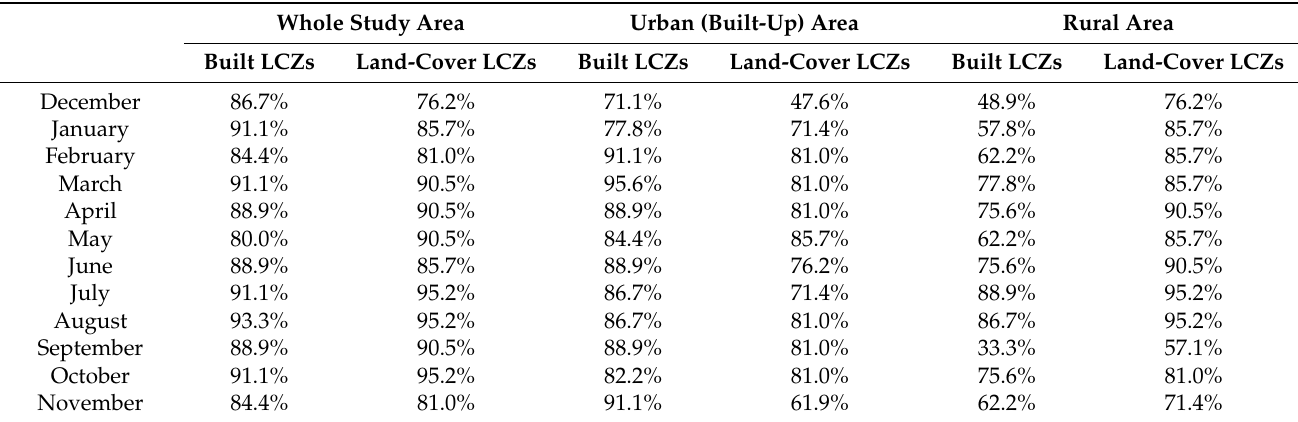
Table 6. An assessment of the capability of local climate zone scheme in differentiating land surface